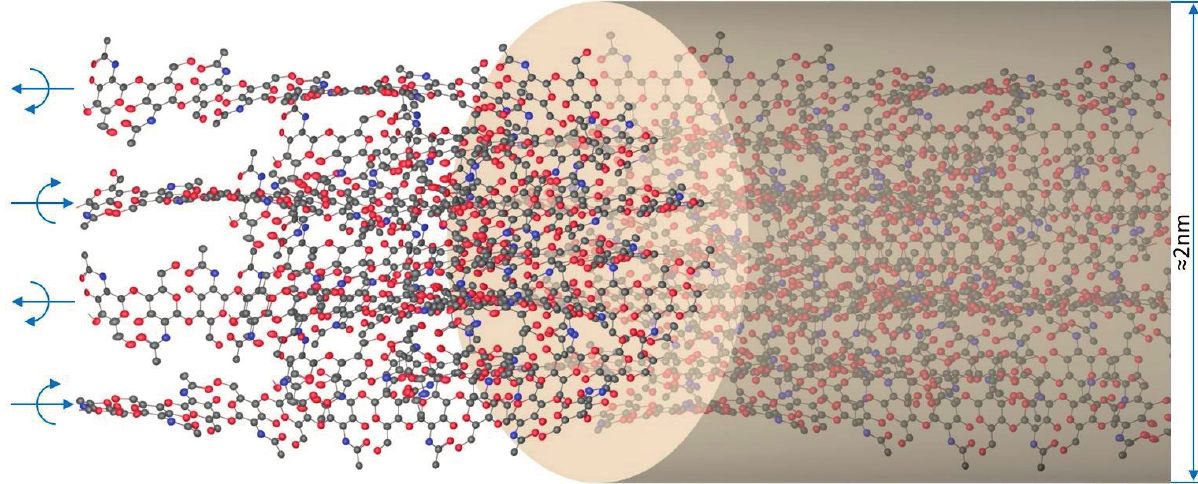
Figure 1. A schematic view of an alpha chitin nanofiber